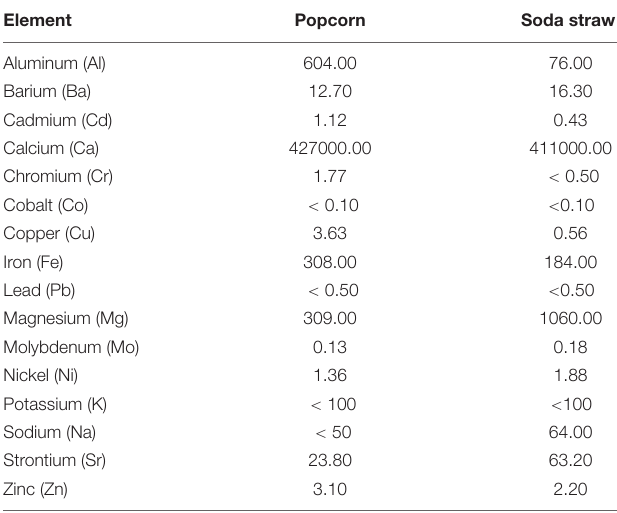
Element Popcorn Soda straw